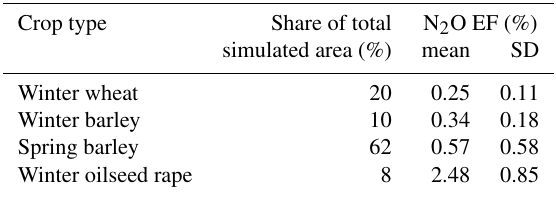
Table 3. Estimated N 2 O EF by type of crop.